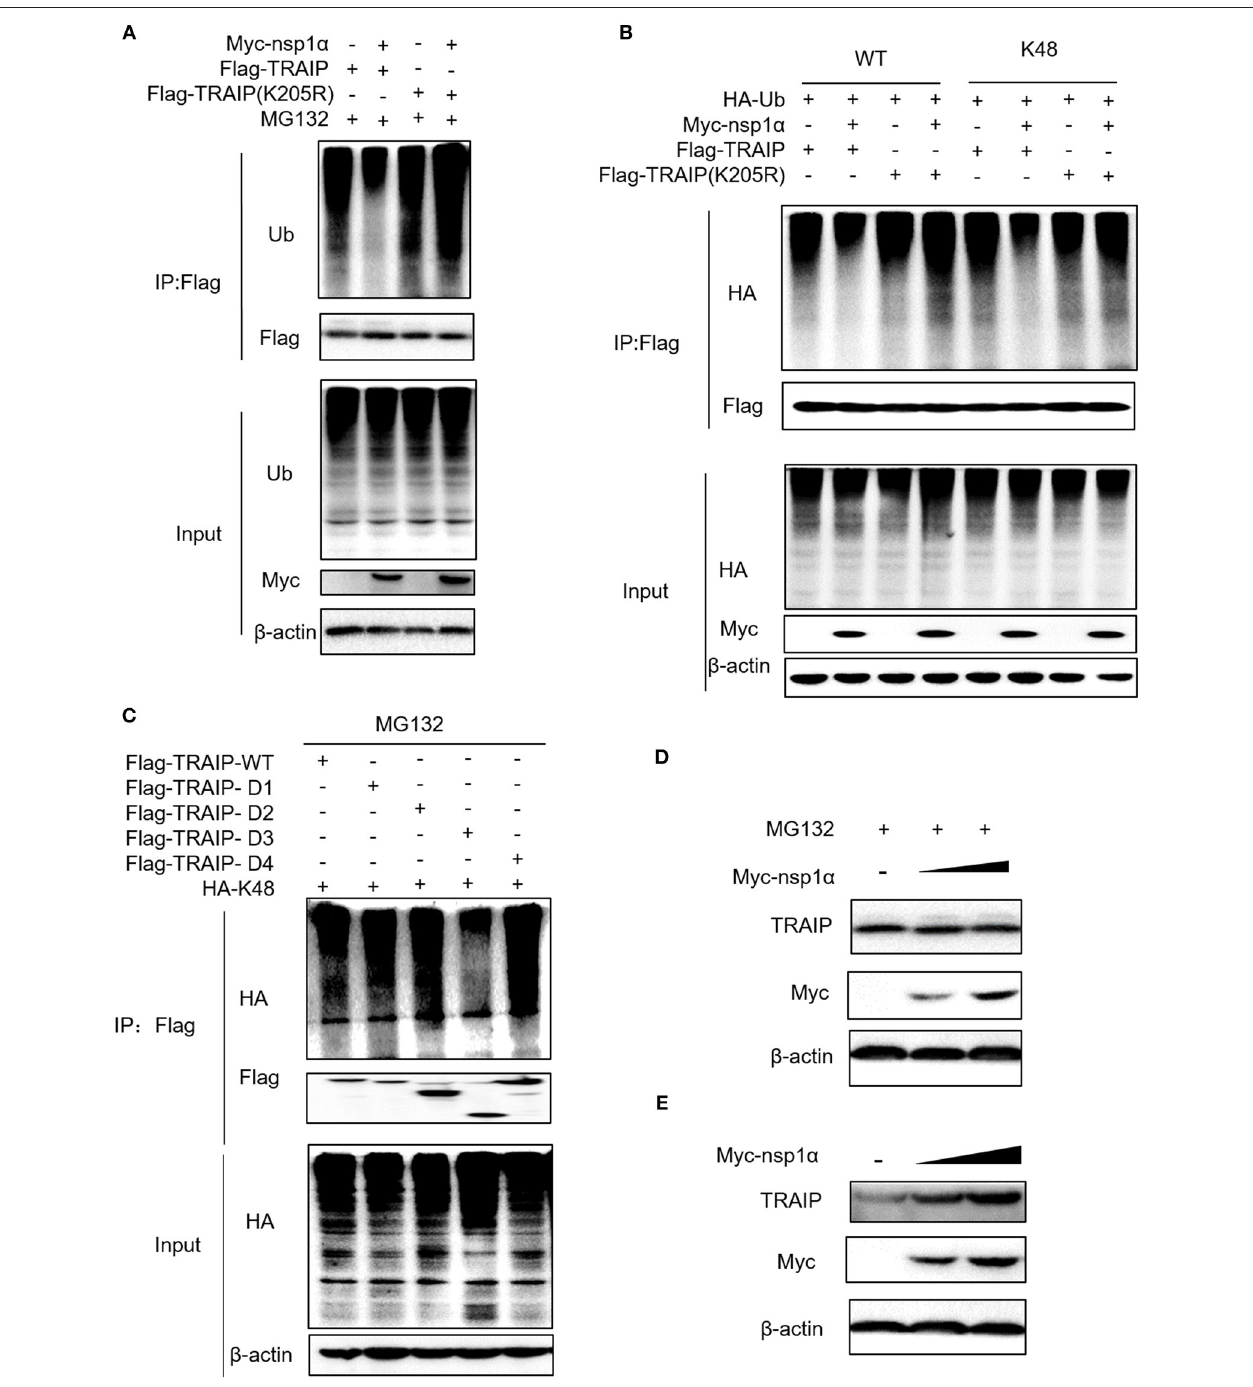
FIGURE 7 | Nsp1 α inhibits K48-linked polyubiquitination and degradation of TRAIP. HEK 293T cells were co-transfected with Flag-TRAIP and Myc-nsp1 α or vector supplemented 10 µ M MG132 (A) . At 24h post-transfection, the cell lysates were co-immunoprecipitated with an anti-Flag and probed with Ub antibody to detect ubiquitin levels of TRAIP respectively by Western blotting. (B) 293T cells were co-transfected with Flag-TRAIP or Flag-TRAIP (K205R), HA-Ub-WT, HA-Ub-K48 (ubiquitin mutants retaining a single lysine residue), and Myc-nsp1 α or vector. At 24h post-transfection, the cell lysates were precipitated with an anti-Flag MAb and further detected by Western blotting with an anti-HA MAb and an anti-Flag. (C) The K48 polyubiquitination of TRAIP was detected in different TRAIP deletion mutants. HEK 293T cells were transfected with Myc-nsp1 α (0.5 or 1.0 µ g) or vector (D,E) . TRAIP expression in total cellular protein and the protein stability of TRAIP in the absence of proteasome inhibitor MG132 (5 µ M) was detected by Western blotting, respectively.